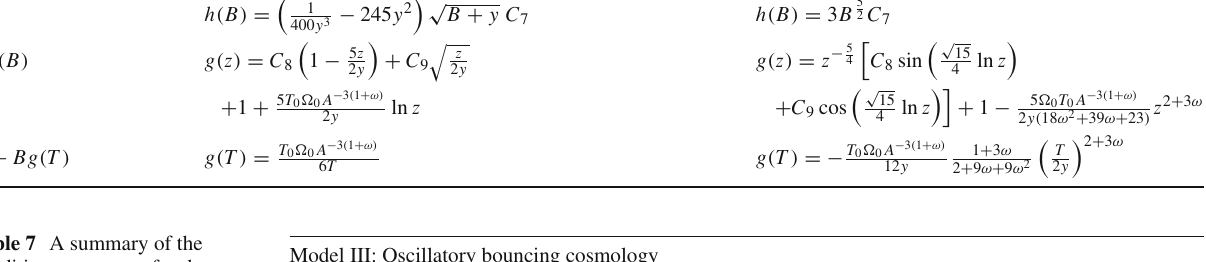
Table 7 A summary of the conditions necessary for the reconstructed oscillatory cosmology Lagrangians to be able to recover vacuum solutions. Only the additive and Tg ( B ) models are capable of